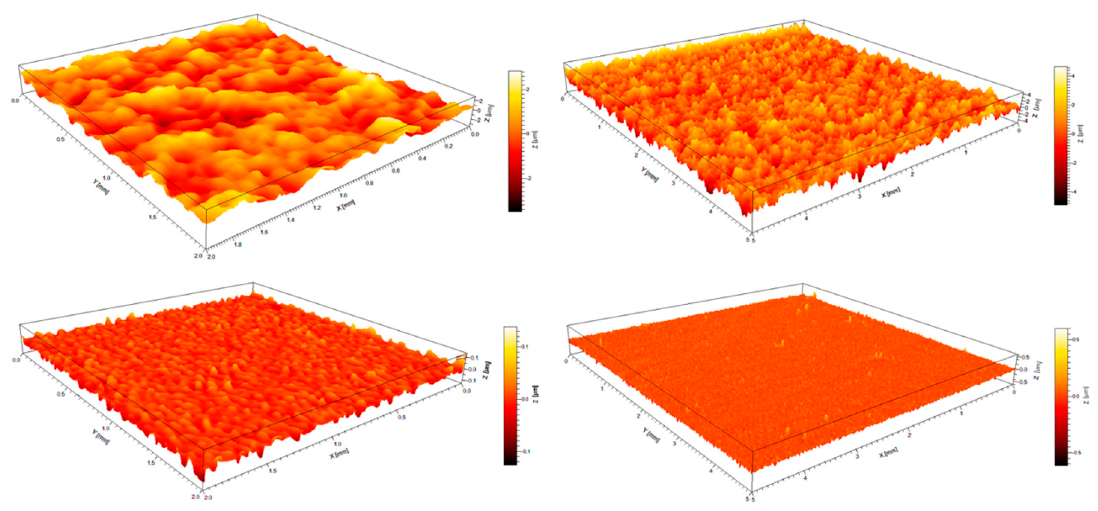
Figure 3. 3D morphologies of typical PU2 and PU4 films in 2 mm ( left ) and 5 mm ( right ) length scales. Upper images are corresponding to PU2 and lower images to PU4 film.